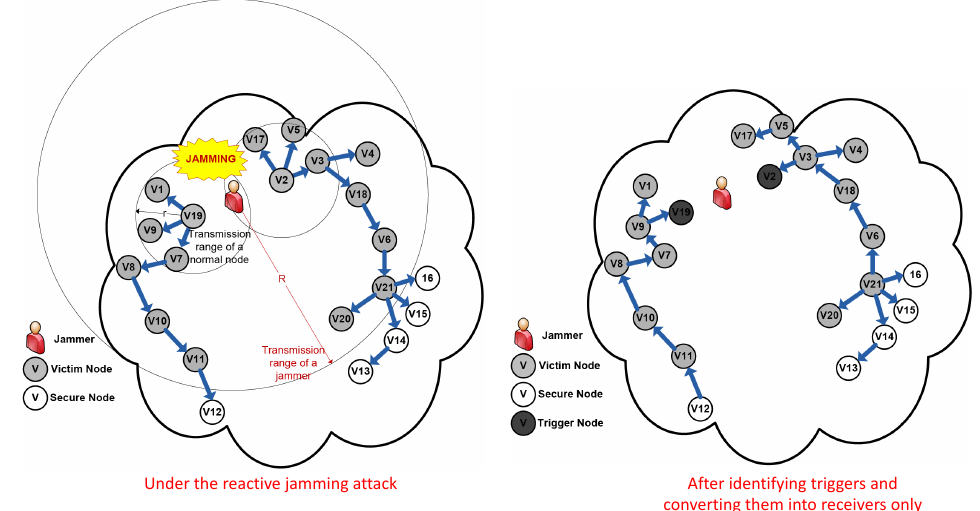
Figure 1. Reactive Jamming Attack and Mitigation by Identification of the